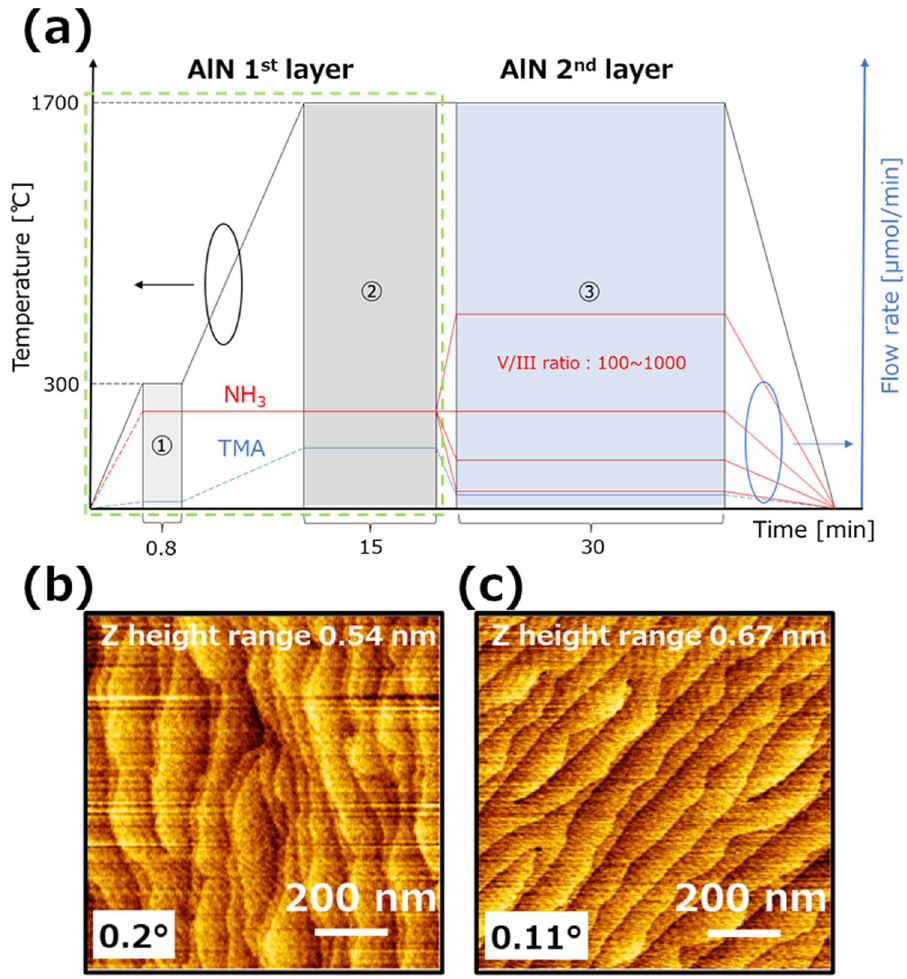
Figure 1. Growth of the first AlN layer. ( a ) The AlN layer’s growth sequence is determined to compare the difference by the V/III ratio. The initial 15 min is a common condition, which is the first AlN layer. ( b ) The AFM image after the first AlN layer grown with sapphire misorientation off-angle of 0.2°. ( c ) The AFM image of the AlN surface after growing the first AlN layer at an off-angle of 0.11°. An atomically flat surface was